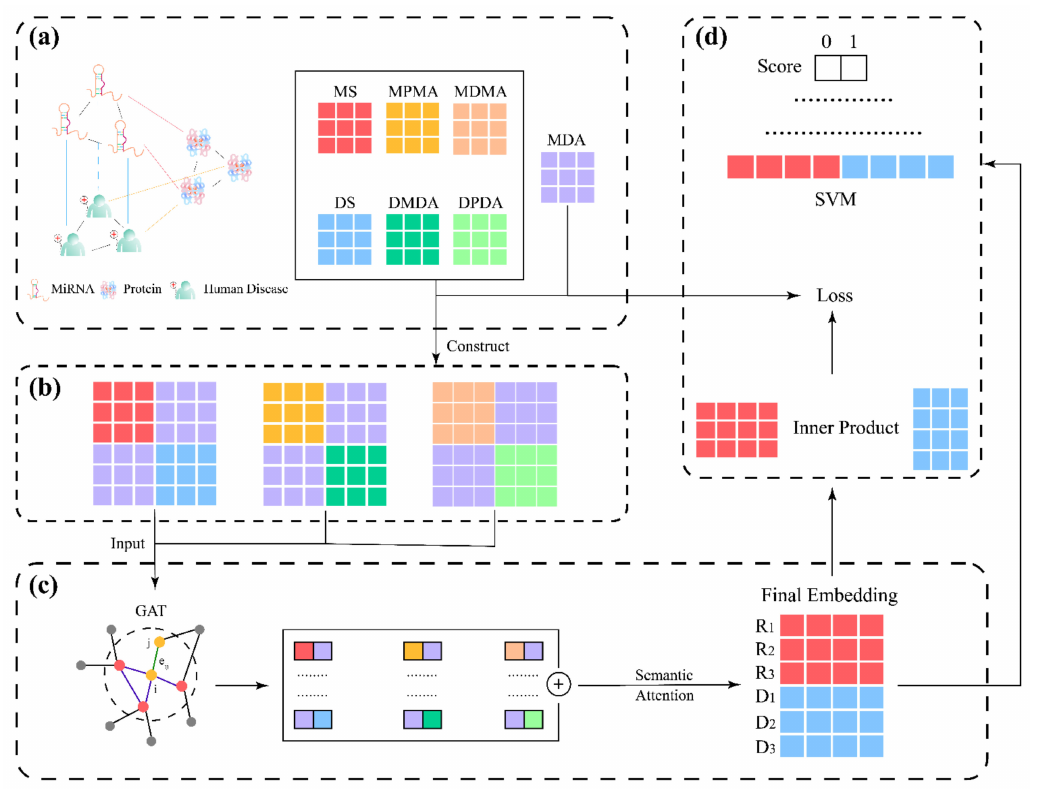
Figure 12. The flowchart of our method. ( a ) Construction of networks; ( b ) Construction of multi- module; ( c ) Feature extraction; ( d ) Model training and